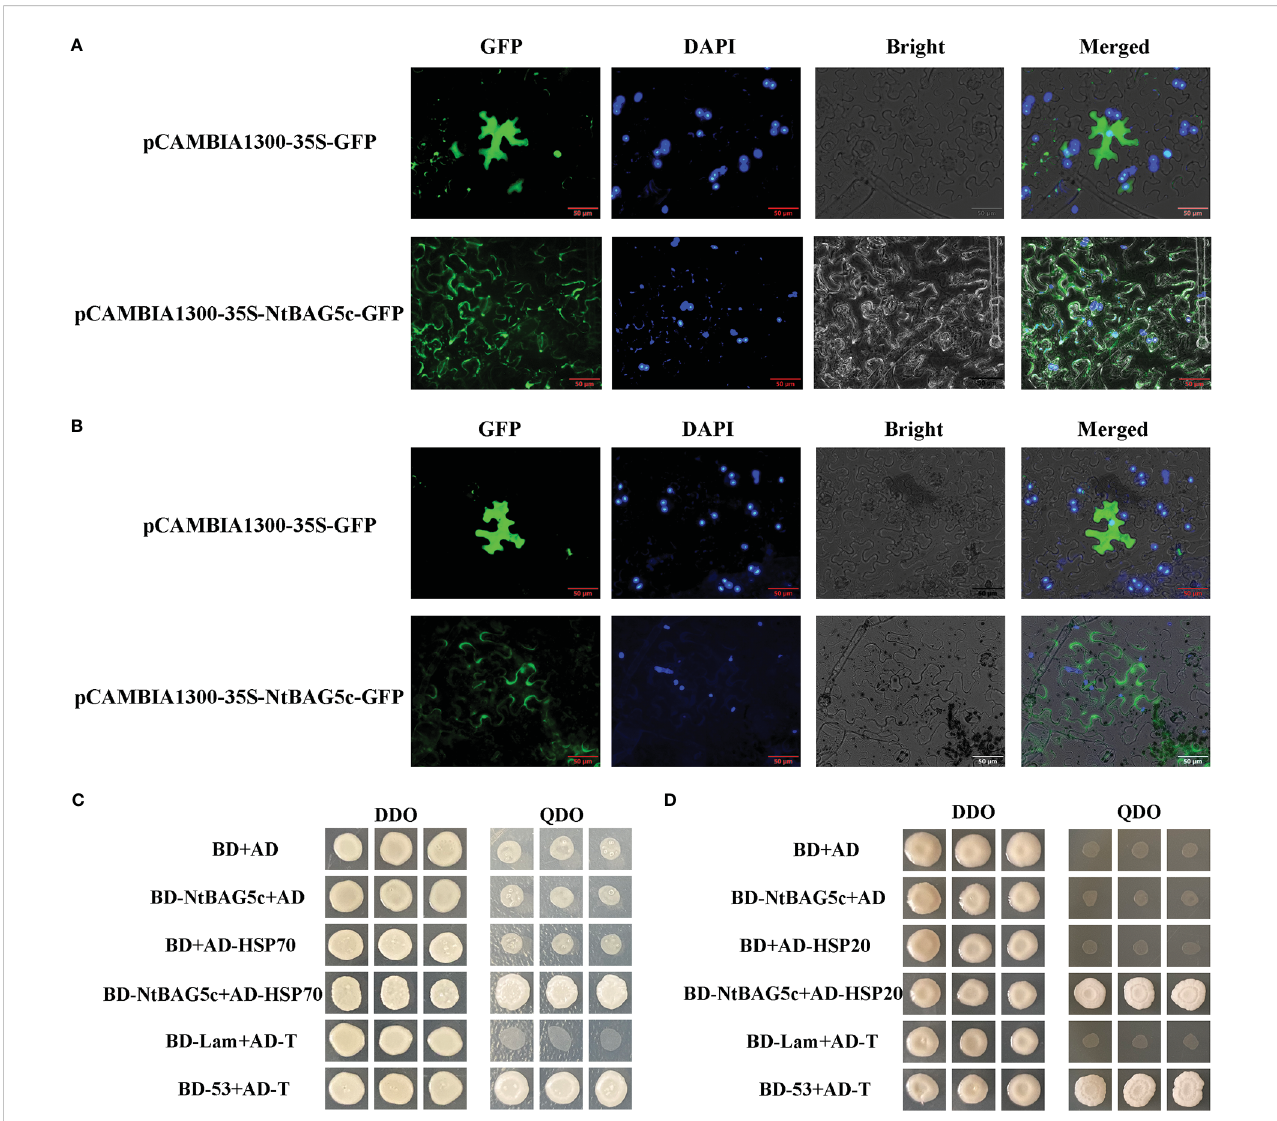
FIGURE 5 Localization of NtBAG5c in epidermal cells of N. benthamiana . (A) Subcellular localization analysis demonstrated that NtBAG5c is located in the cell membrane and cell wall. (B) After the wall separation, subcellular localization analysis indicated that NtBAG5c is located in the cell wall. GFP, green fl uorescent protein; DAPI, fl uorescent dye capable of binding strongly to DNA; Bright, white light; Merged, superposition of GFP, DAPI, and Bright. (C, D) Yeast two-hybrid assay. (C) The interaction of NtBAG5c and HSP70 in yeast cells. (D) The interaction of NtBAG5c and HSP20 in yeast cells. BD-53 + AD-T and BD + AD were used as positive and negative controls, respectively. The yeast co-transformed groups were grown on the SD Leu-Trp medium [double dropout (DDO), without leucine and tryptophan], and then grown on SD-Leu-Trp-His-Ade medium [quadruple dropout (QDO), with leucine, tryptophan, histidine, and